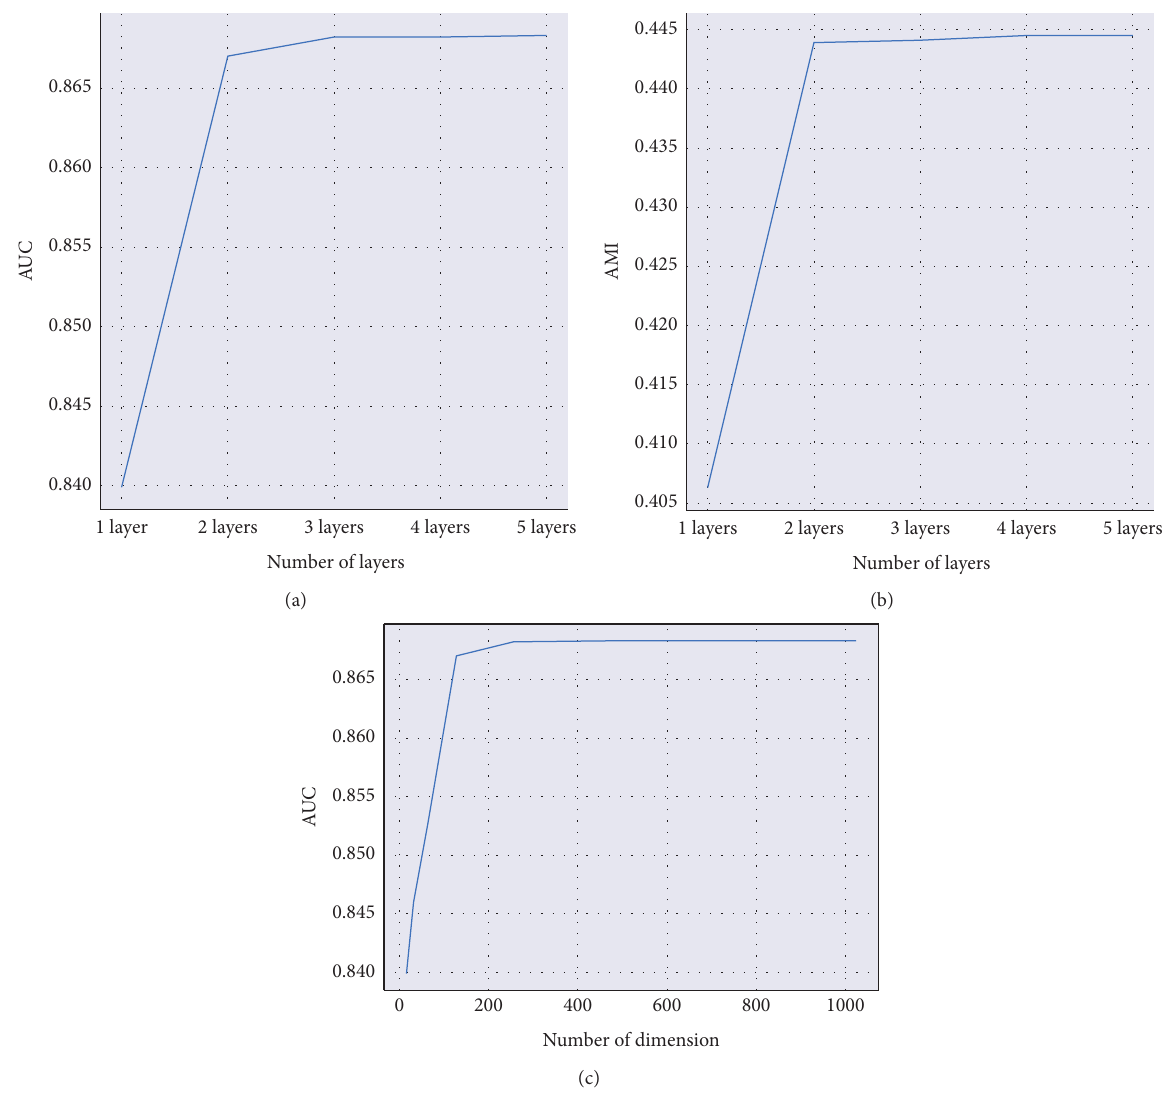
Figure 4: Impact of different experimental settings on our model’s performance in the link prediction task: (a) the effect of layer’s number on the AUC value, (b) the effect of layer’s number on the AMI value, and (c) the effect of dimension on the AUC